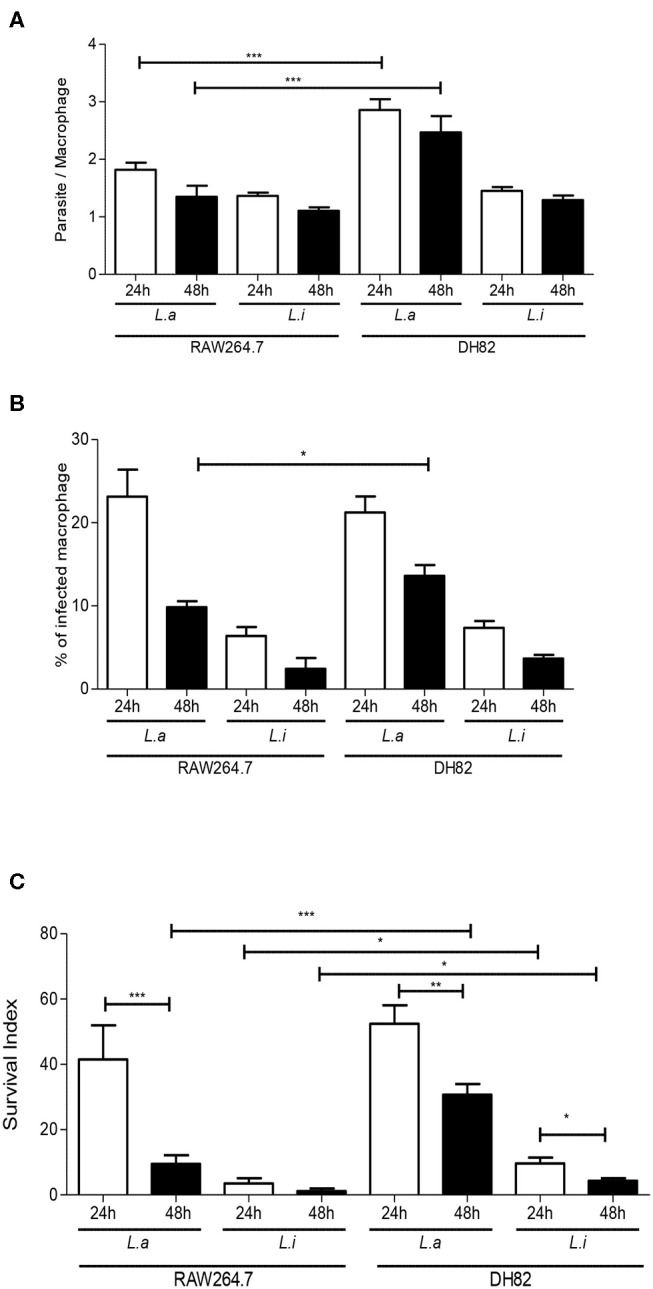
Leishmania interaction with macrophages. Parasite per macrophages (A), % infected-macrophages (B), and survival index (C) in canine DH82 and murine RAW264.7. Macrophages were infected with L. amazonensis (L.a) and L. infantum (L.i) promastigotes (5 parasites: 1 macrophage) for 24 and 48 h. The data represent mean ± SEM of six independent experiments done in triplicates. **p < 0.008; *p < 0.05; ***p < 0.0001.